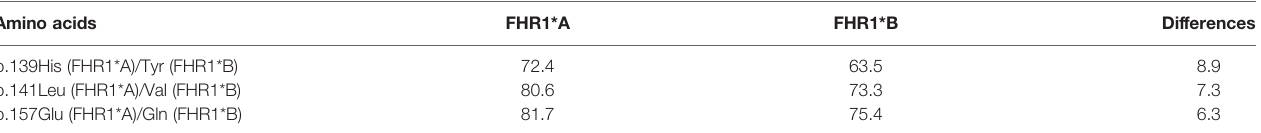
TABLE 1 | The included angles of SCR3 to SCR4-5 in FHR1*A and FHR1*B. Amino